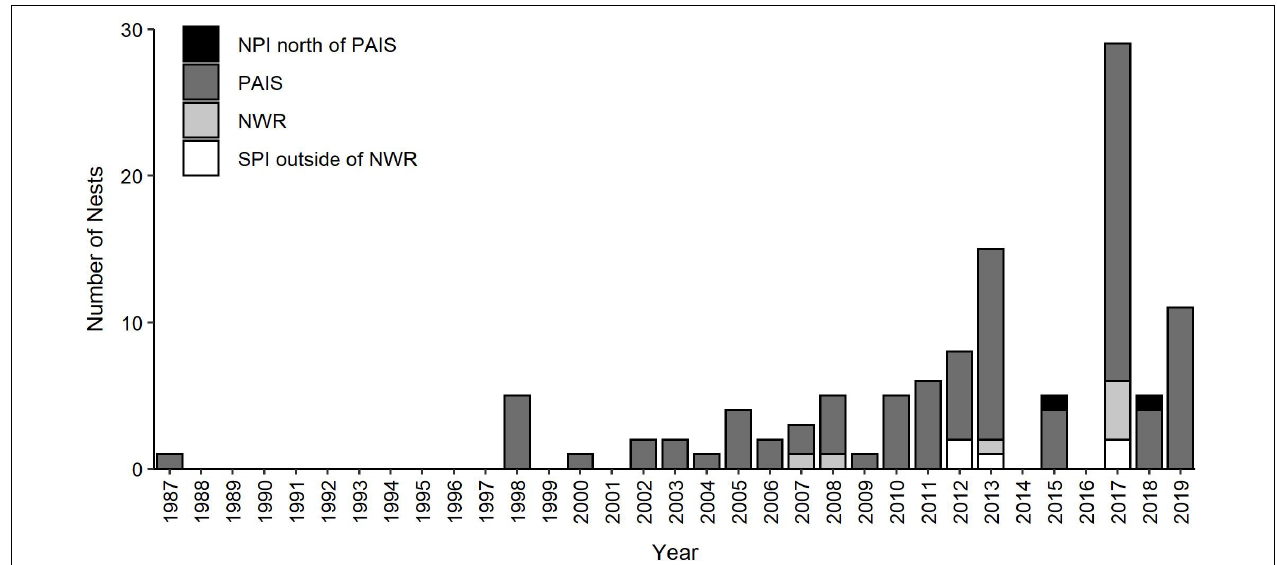
FIGURE 2 | Annual numbers of green turtle ( Chelonia mydas ) nests documented in Texas from 1987 to 2019 (non-nesting emergences not included). NPI = North Padre Island outside of PAIS, PAIS = Padre Island National Seashore, NWR = Laguna Atascosa and Lower Rio Grande National Wildlife Refuges, SPI = South Padre Island outside of a NWR.